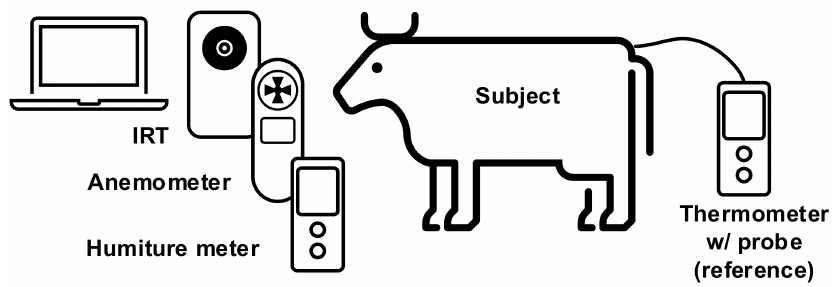
Figure 1. Experimental setup of the proposed system architecture.